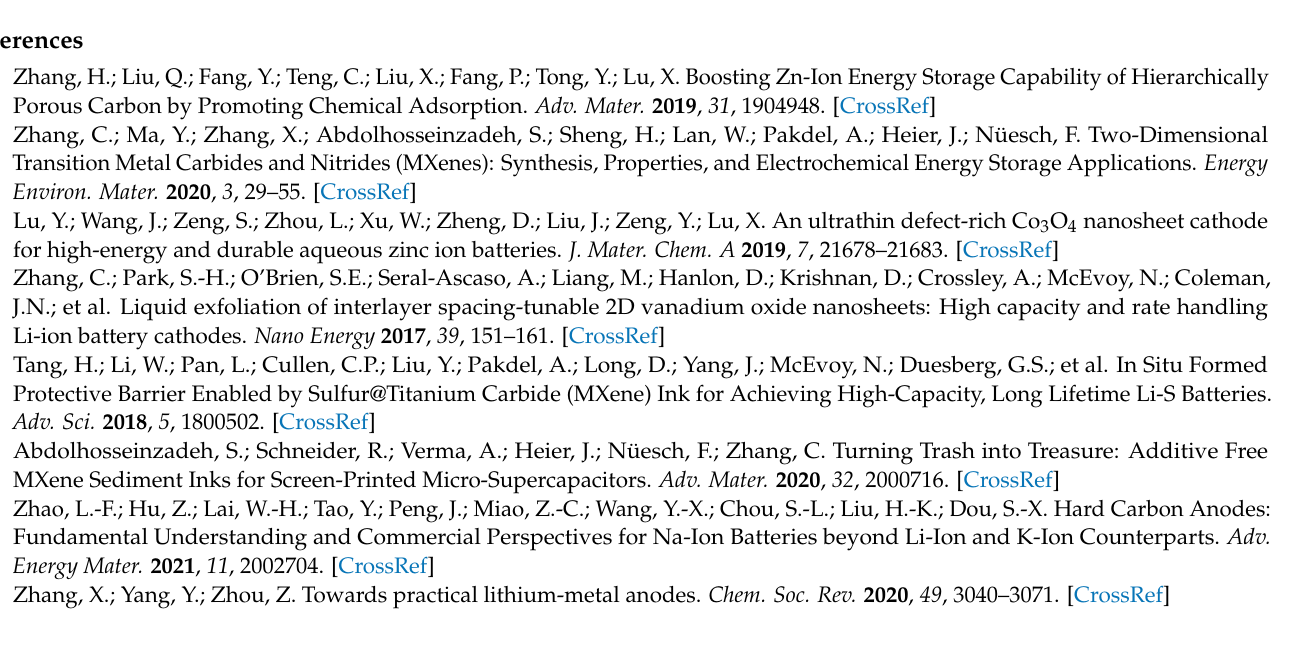
Figure S2: 13 C CP/MAS NMR spectra of HCPB; Figure S3: The XPS spectrum of CHCPB; Figure S4: (a) The rate property and (b) long-term running property at 2 A g − 1 of commercial hard carbon (CHC); Figure S5: Galvanostatic charge–discharge curves of (a) HCPB and (b) CHCPB at 2 A g − 1 . Figure S6: The EIS fitting circuit model of HCPB and CHCPB electrodes; Figure S7: EIS of the HCPB electrode before (a) and after cycling (b); Table S1. The elemental composition determined by EA. Table S2. Comparison of the electrochemical performances with some reported polymers-derived carbon